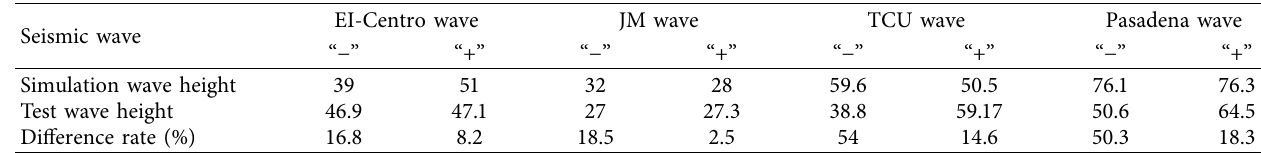
Figure 5: Finite element model of storage tank. (a) Tank model. (b) Contact model. Table 2: Simulation and test wave heights (in millmeters).